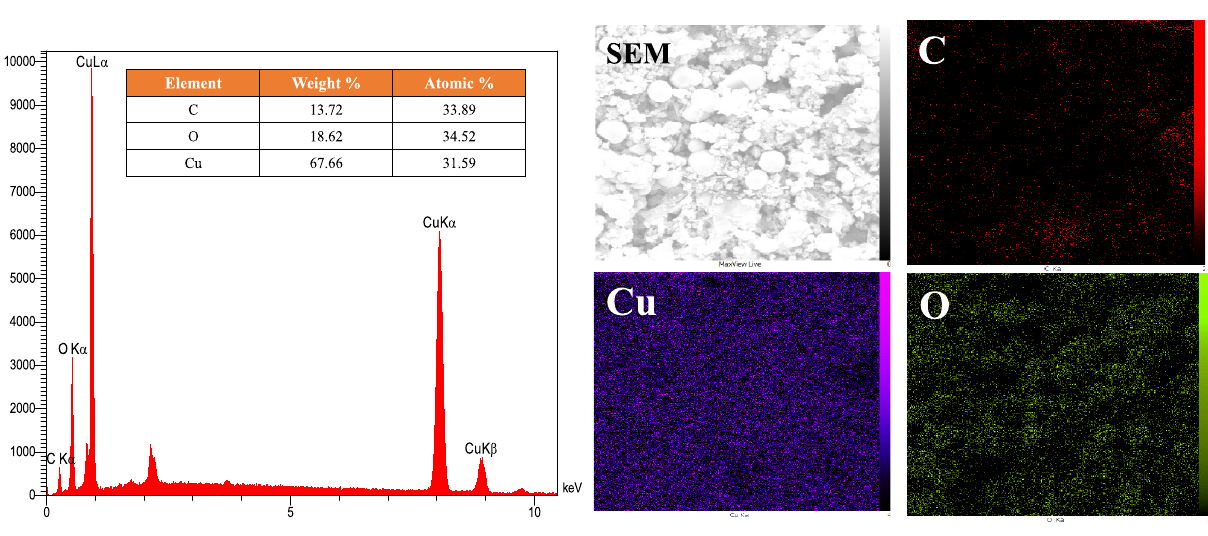
Figure 9. EDX and elemental mapping of